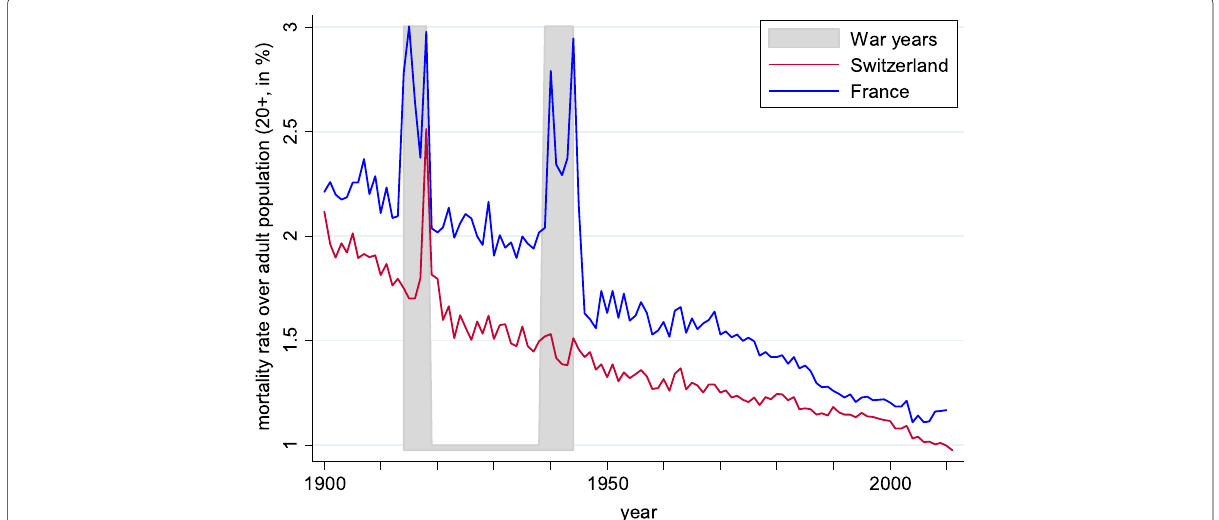
Fig. 2 Adult mortality rates. Notes: data for France from Piketty (2011). See text for Swiss data